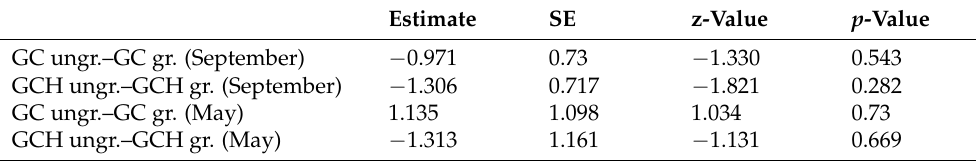
Table A22. Differences in activity densities of agrotopic carabid beetles, comparing the grazed pastures and ungrazed strips of the grass–clover (GC) and the grass–clover herbs (GCH) in May/June and September.